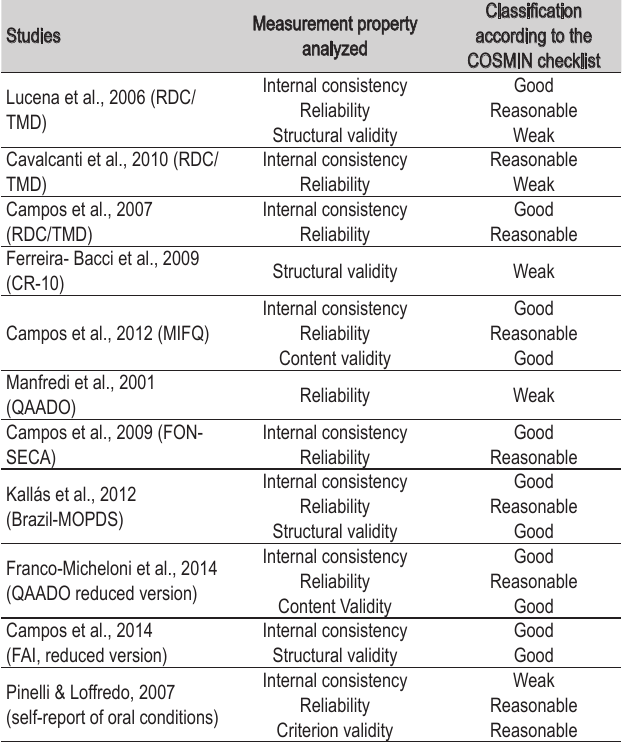
Table 2 - Classification of questionnaires related to TMD according to the COSMIN